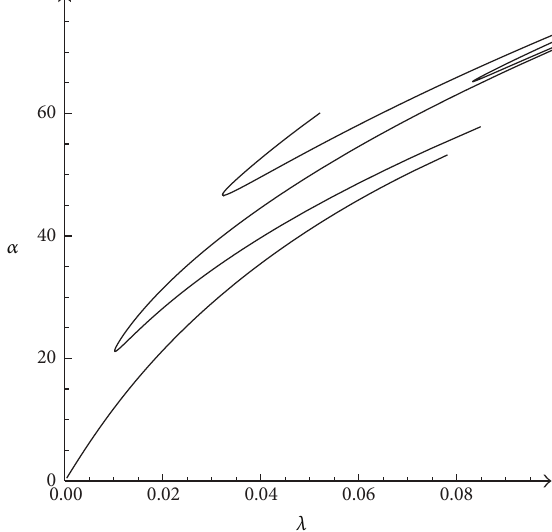
Figure 19: The bifurcation diagram for Example 2 .